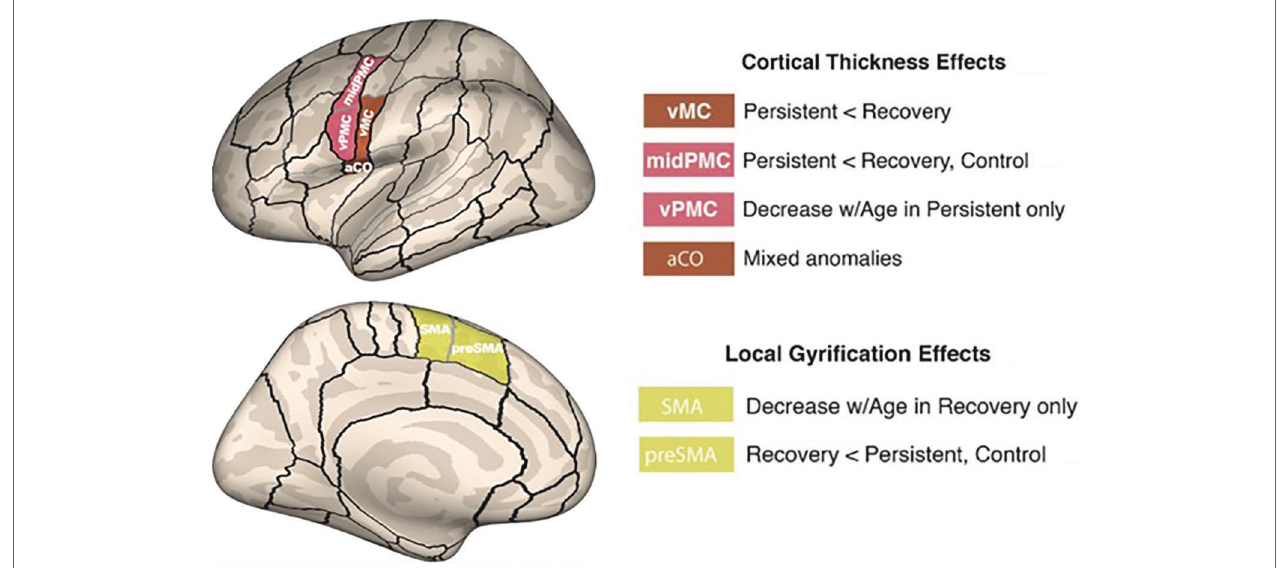
FIGURE 5 | Morphometric differences in speech motor control regions differentiated children with persistent stuttering from those who recover. A compensatory mechanism involving left medial premotor cortex may contribute to recovery (Garnett et al., 2018). Reprinted from Garnett et al. (2018), by permission of Oxford University Press. Copyright © 2018 Oxford University